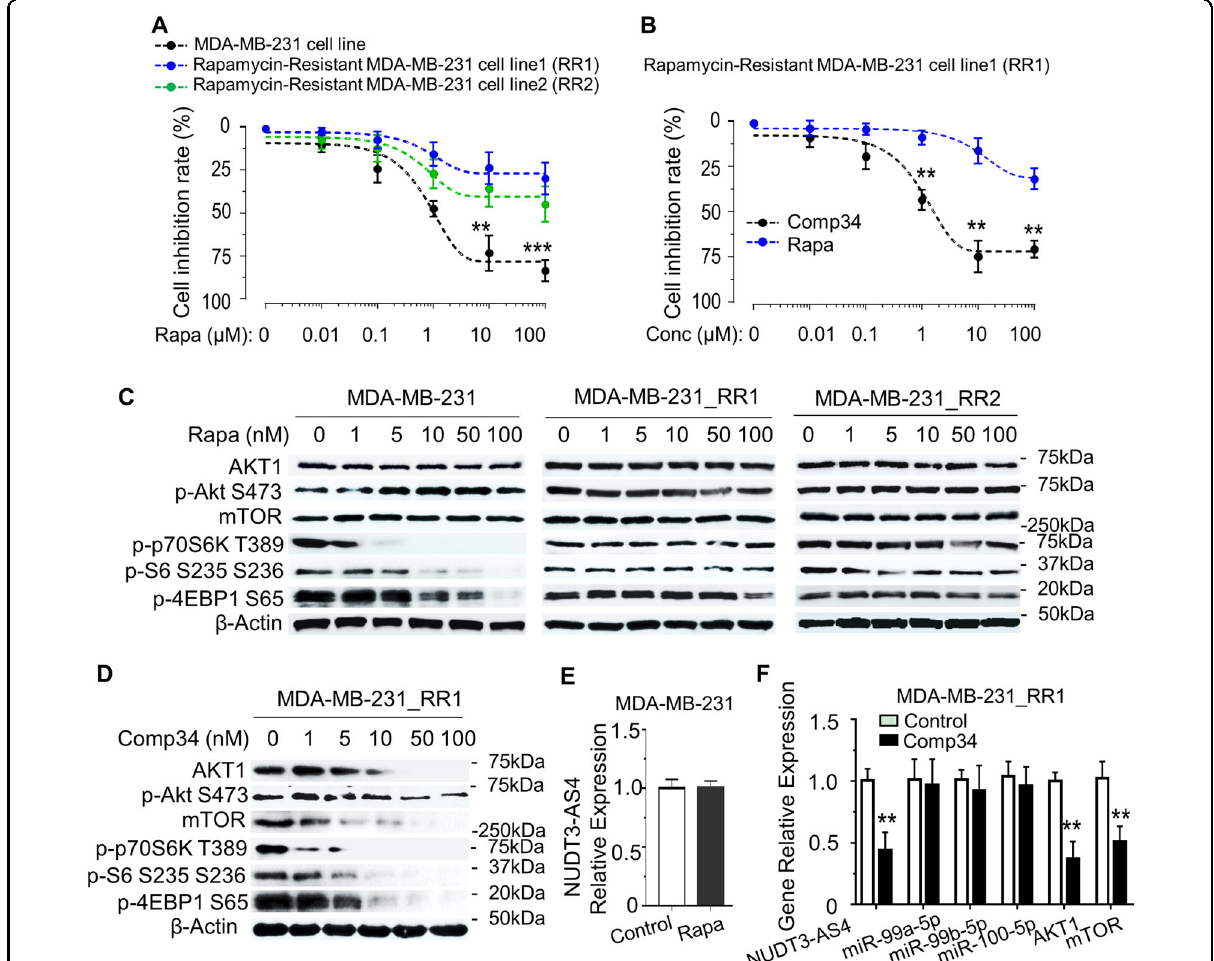
Fig. 6 Comp34 targets and inhibits mTOR through cellular mechanisms different from rapamycin. a MDA-MB-231 and rapamycin-resistant MDA-MB-231 cell lines (RR1, RR2) were treated with the indicated concentrations of rapamycin for 48 h. MTS cell proliferation assay was performed to determine the cell growth inhibition. Each dot and error bar on the curves represents mean ± SD ( n = 6). b RR1 cells were treated with Comp34 or rapamycin for 48 h. The cell growth inhibition was determined. Each dot and error bar on the curves represents mean ± SD ( n = 6). c AKT/mTOR signaling was assessed by WB using the indicated protein-speci fi c antibodies. d RR1 cells were treated with the indicated concentrations of Comp34 for 24 h. AKT/mTOR signaling was evaluated by WB. e MDA-MB-231 cells were treated with 100 nM rapamycin for 24 h. RT-PCR was performed to measure NUDT3-AS4 level. f RR1 cells were treated with or without 100 nM Comp34 for 24 h. RT-PCR was performed to measure NUDT3-AS4, miR-99s levels, and AKT1/mTOR mRNA levels. ** P < 0.01 versus